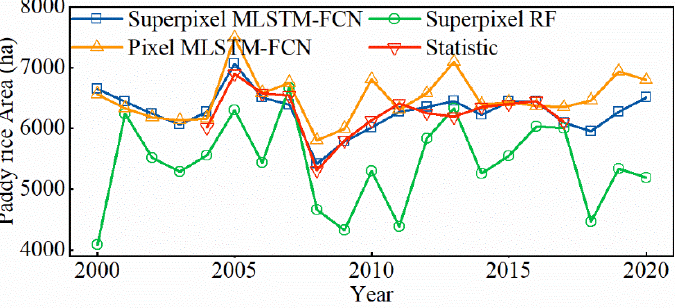
Figure 7. The coefficient of determination ( 𝑅 2 ) in areas between model-mapped paddy rice and statistics was 0.868, 0.538, and 0.242 for the superpixel MLSTM-FCN, pixel MLSTM-FCN, and pixel MLSTM-FCN, respectively. The root mean square error (RMSE) was 143.060 ha, 306.267 ha, and 625.426 ha for the superpixel MLSTM-FCN, pixel MLSTM- FCN, and pixel MLSTM-FCN, respectively.